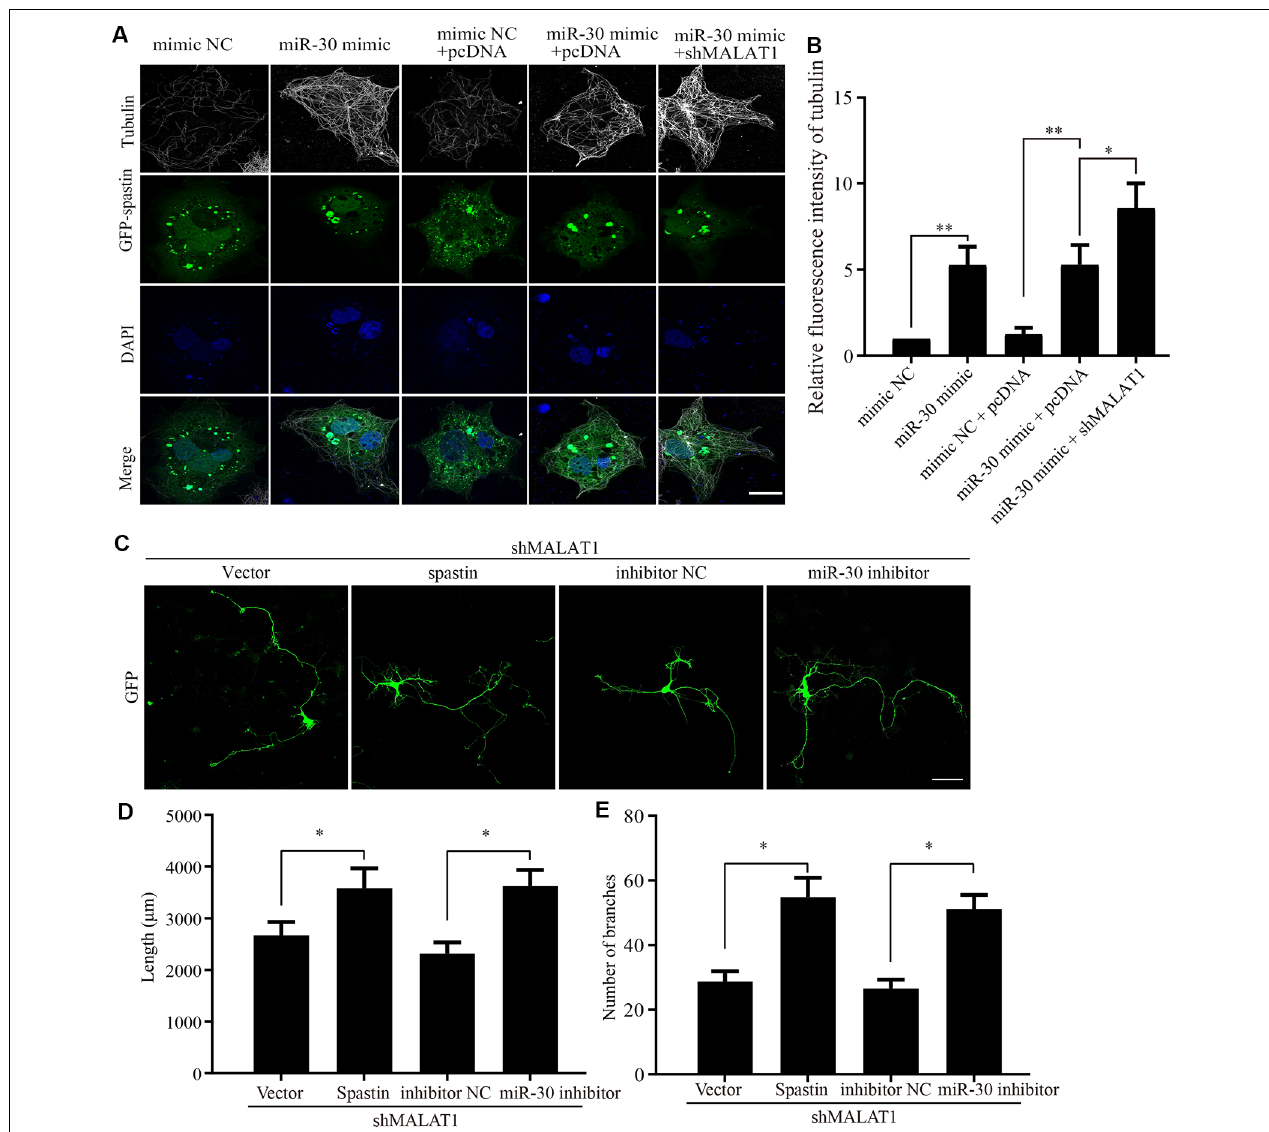
FIGURE 6 | MALAT1/miR-30/spastin signaling axis regulates microtubule severing and neurite outgrowth. (A) COS1 cells were transfected with the GFP-spastin plasmid together with the miR-30 mimic, the miR-30 mimic plus shMALAT1, or controls. The cells were then subjected to immunofluorescent antibody staining for tubulin (white) and GFP (green). Nuclei are stained with DAPI (blue). Representative images are shown; Scale bar, 25 µ m. (B) The relative fluorescence intensities of tubulin in (A) were quantified ( n = 3; cell number > 50/group of each repeat). ∗ P < 0.05, ∗∗ P < 0.01. The cultured neurons were co-transfected with the shMALAT1 plasmid together with spastin encoding plasmids or the miR-30 inhibitor fragments. Then, the neurons were subjected to immunofluorescence for morphological analysis. Representative images are shown in (C) . Neurite lengths (D) and the number of branches (E) were also measured ( n = 3; neuron number > 30/group for each repeat). ∗ P < 0.05; Scale bar, 50 µ